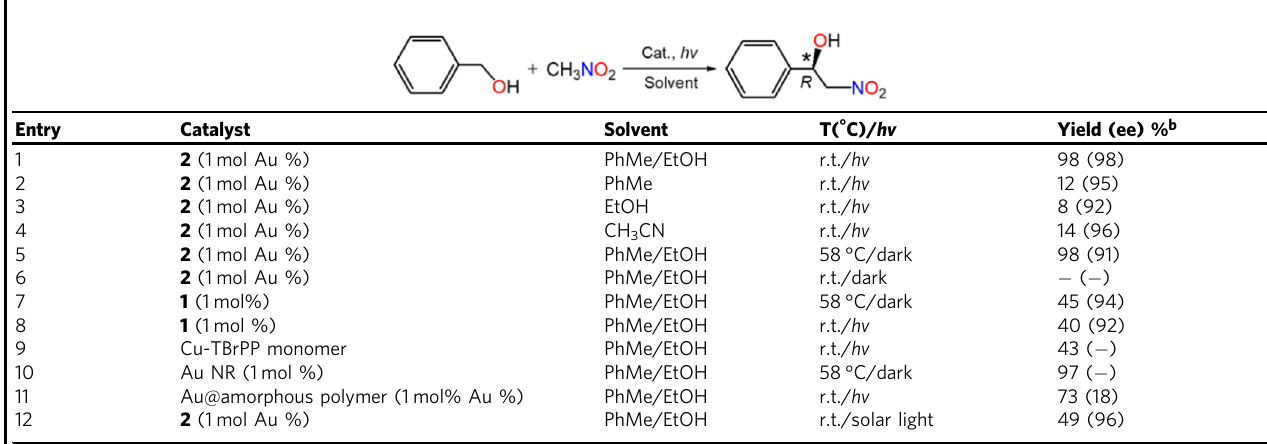
Table 1 Optimization of the 2-catalyzed model one-pot asymmetric Henry reaction a